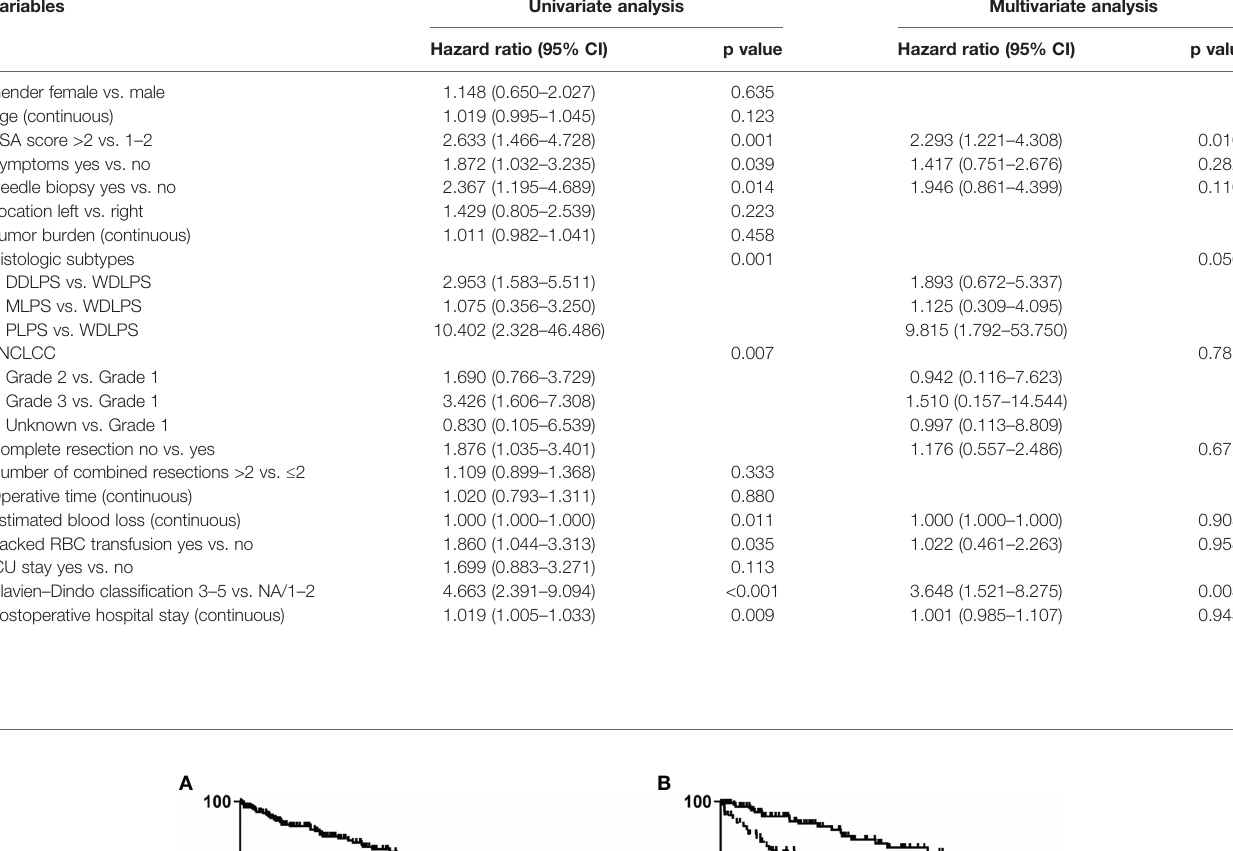
Gender female vs. male